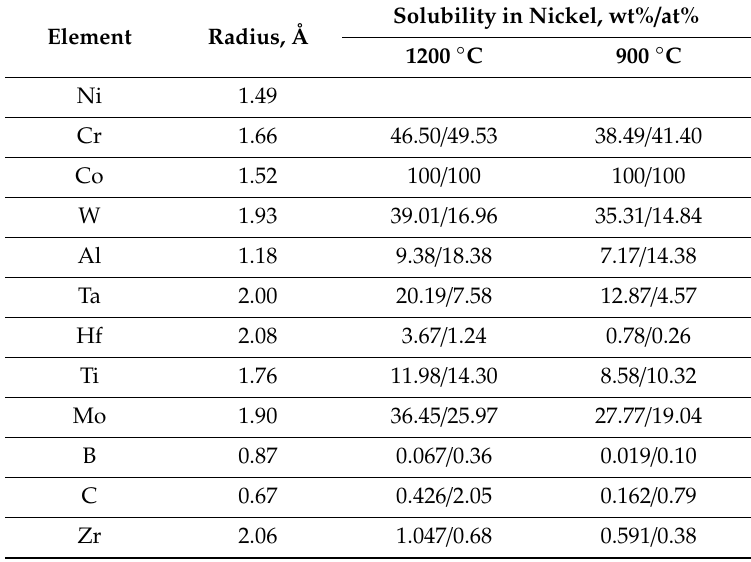
Table 2. Solubility of selected alloying elements in nickel at 1200 ◦ C and 900 ◦ C. Calculated by